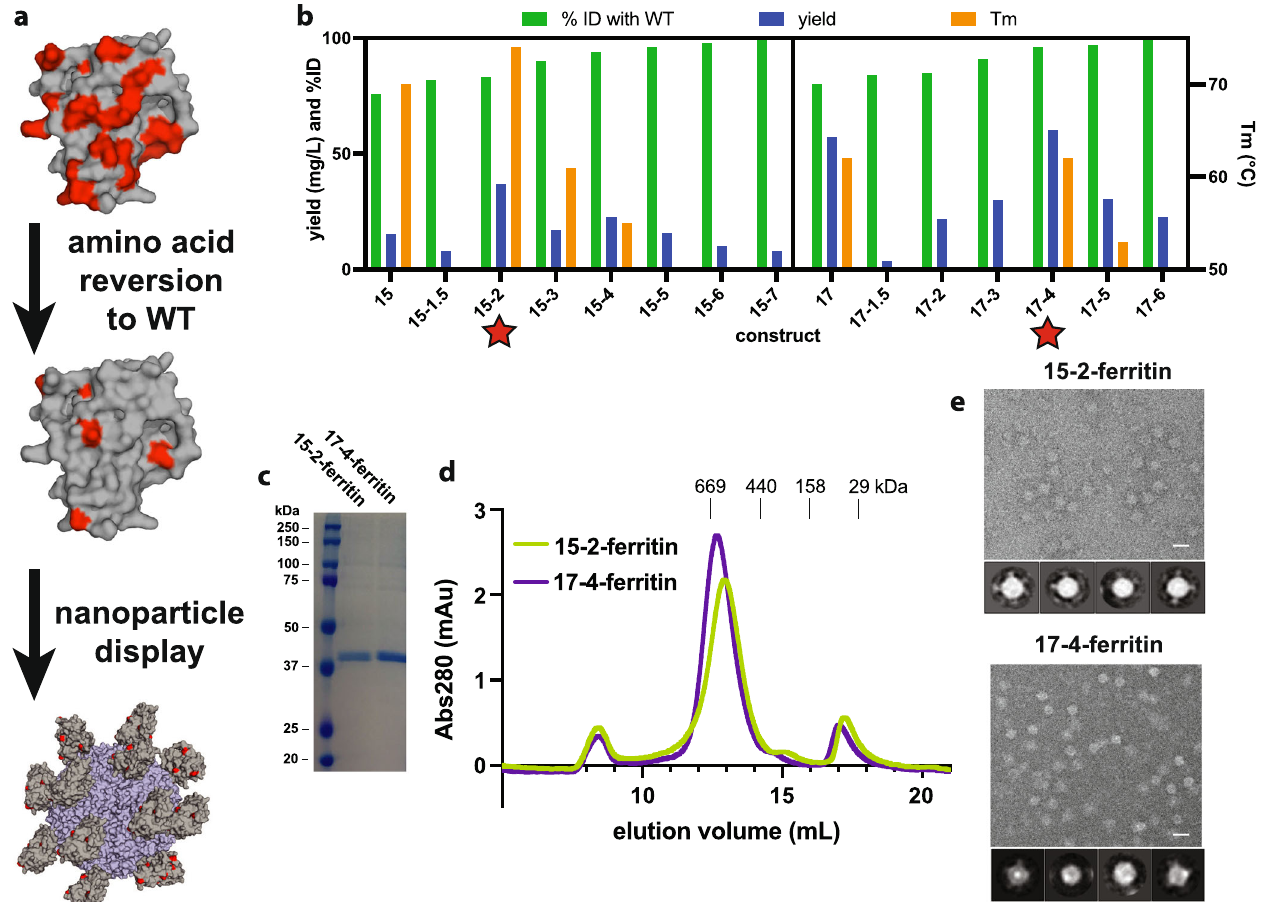
Fig. 3 Creation of nanoparticles displaying optimized immunogens. a Antigen optimization process fi rst reverting designed amino acids (red) back to WT identity (gray), followed by display on a 24-copy ferritin nanoparticle (blue). b Screening of optimized immunogen monomers. Nickel puri fi cation yields are reported for all constructs. T m was measured for those constructs with suf fi cient yields. Immunogens 15-2 and 17-4 were identi fi ed as optimized leads for nanoparticle display. c SDS-PAGE analysis of puri fi ed immunogens fused with ferritin. d Size-exclusion chromatogram of puri fi ed particles after freeze thaw, indicating formation of a stable particle. e Negative-stain EM micrographs of puri fi ed nanoparticles displaying optimized immunogens. Scale bars are 20 nm. The 2D class averages are shown below each